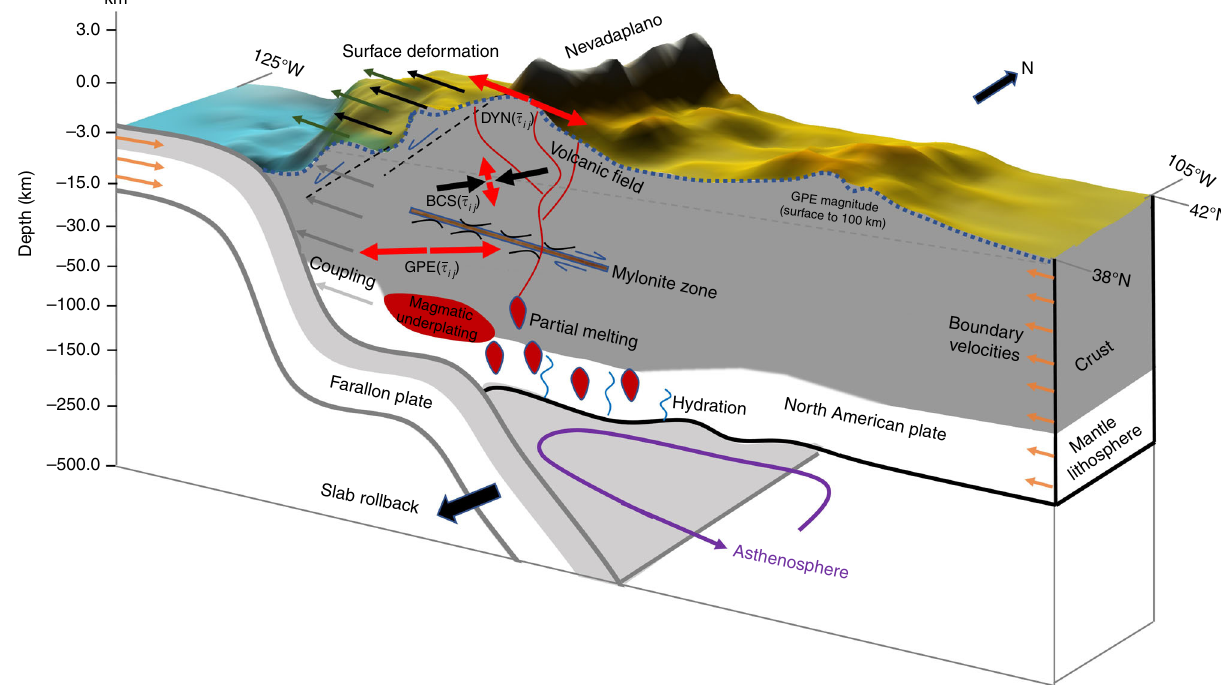
Fig. 2 Primary driving forces for deformation of the continental lithosphere. A schematic of inputs and outputs for estimating primary driving forces in our geodynamic calculations. GPE ð (cid:1) τ ij Þ represents deviatoric stress associated with gravitational potential energy gradients. BCS ð (cid:1) τ ij Þ represents boundary condition stress associated with plate motion. DYN ð (cid:1) τ ij Þ represents dynamic deviatoric stresses from our iterative dynamic